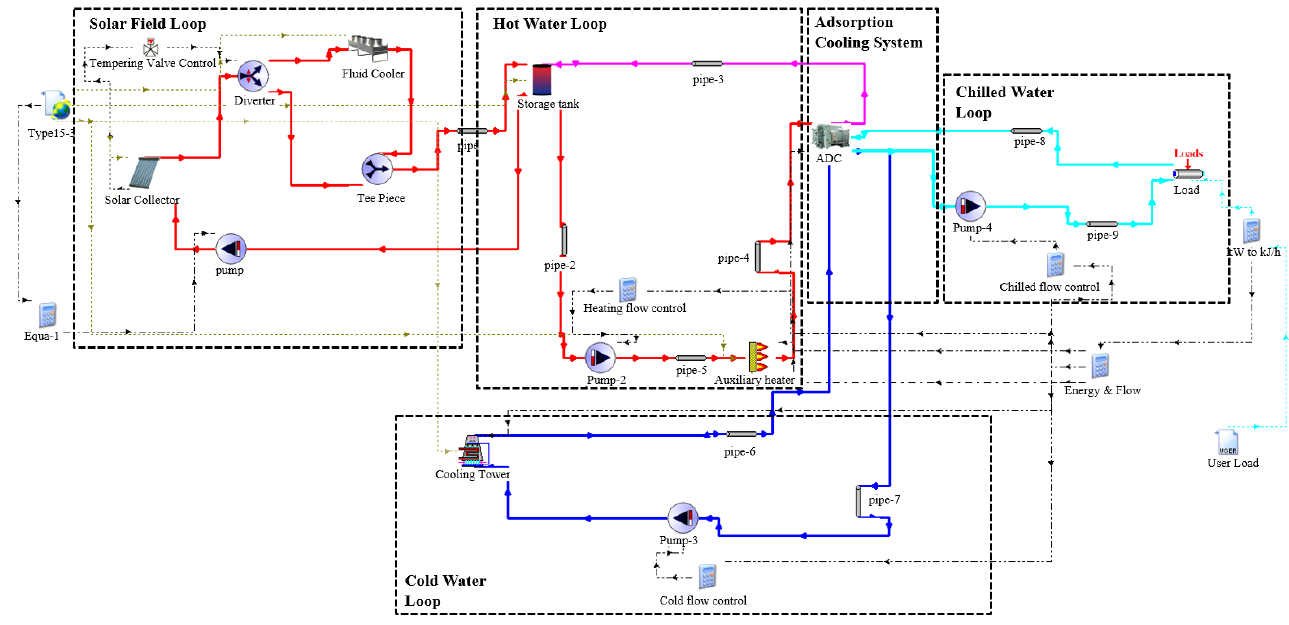
Figure 4. TRNSYS schematic of the proposed solar adsorption chiller system showing the different parts of the